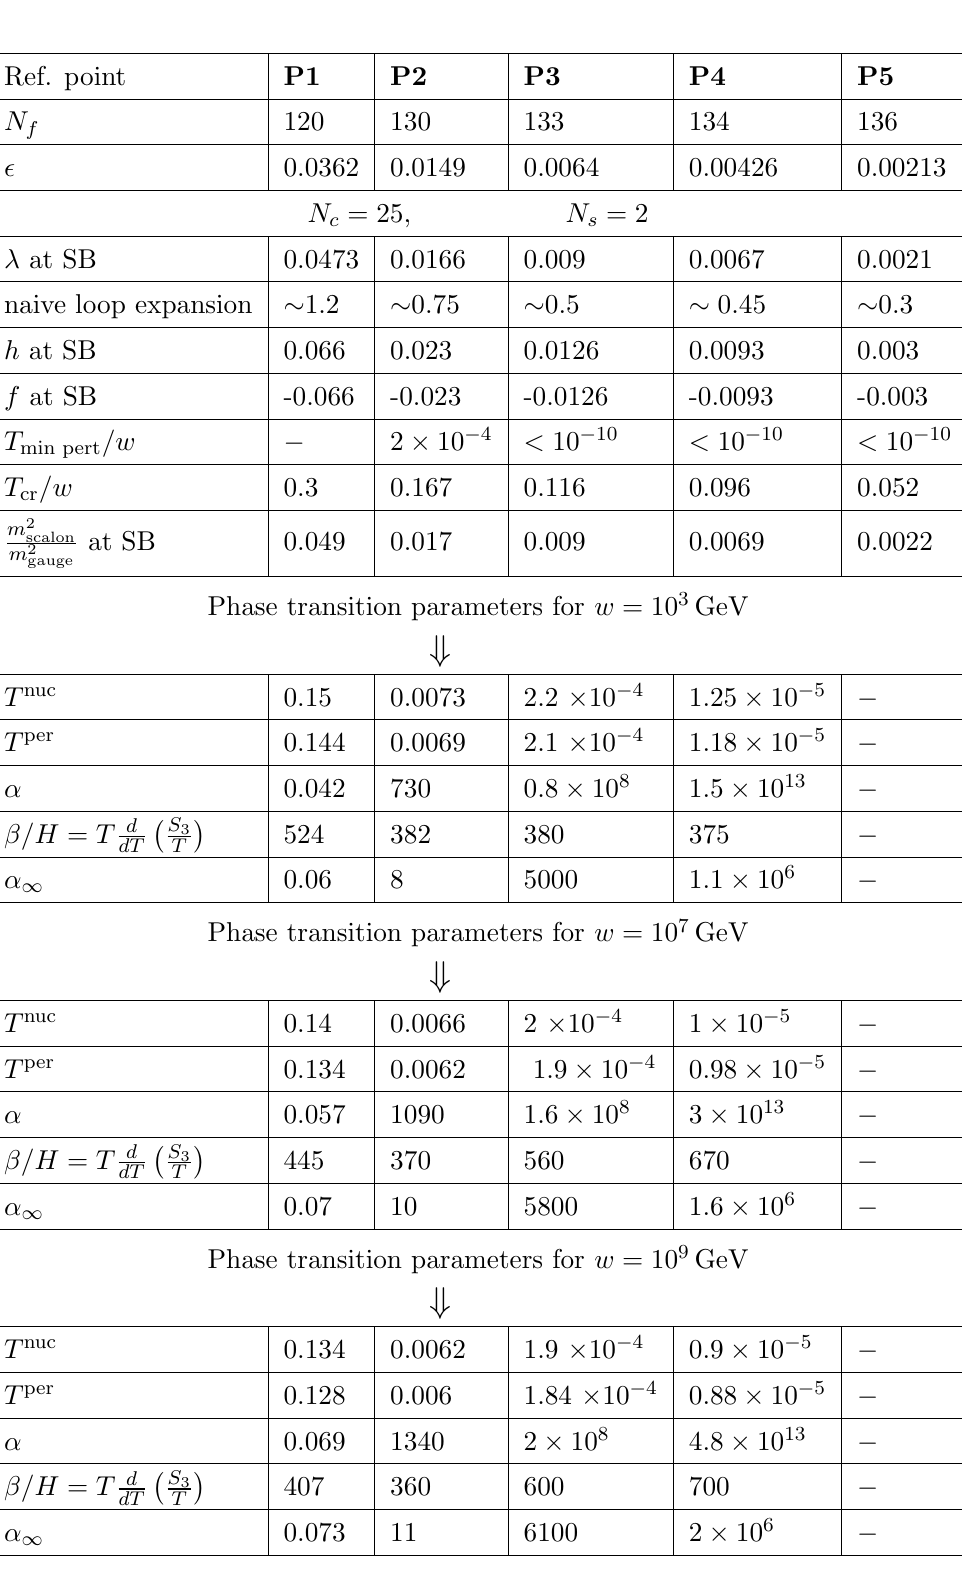
Table 4 . Same as table 3 for the values of the scale w = 10 3 ; 10 7 ; 10 9